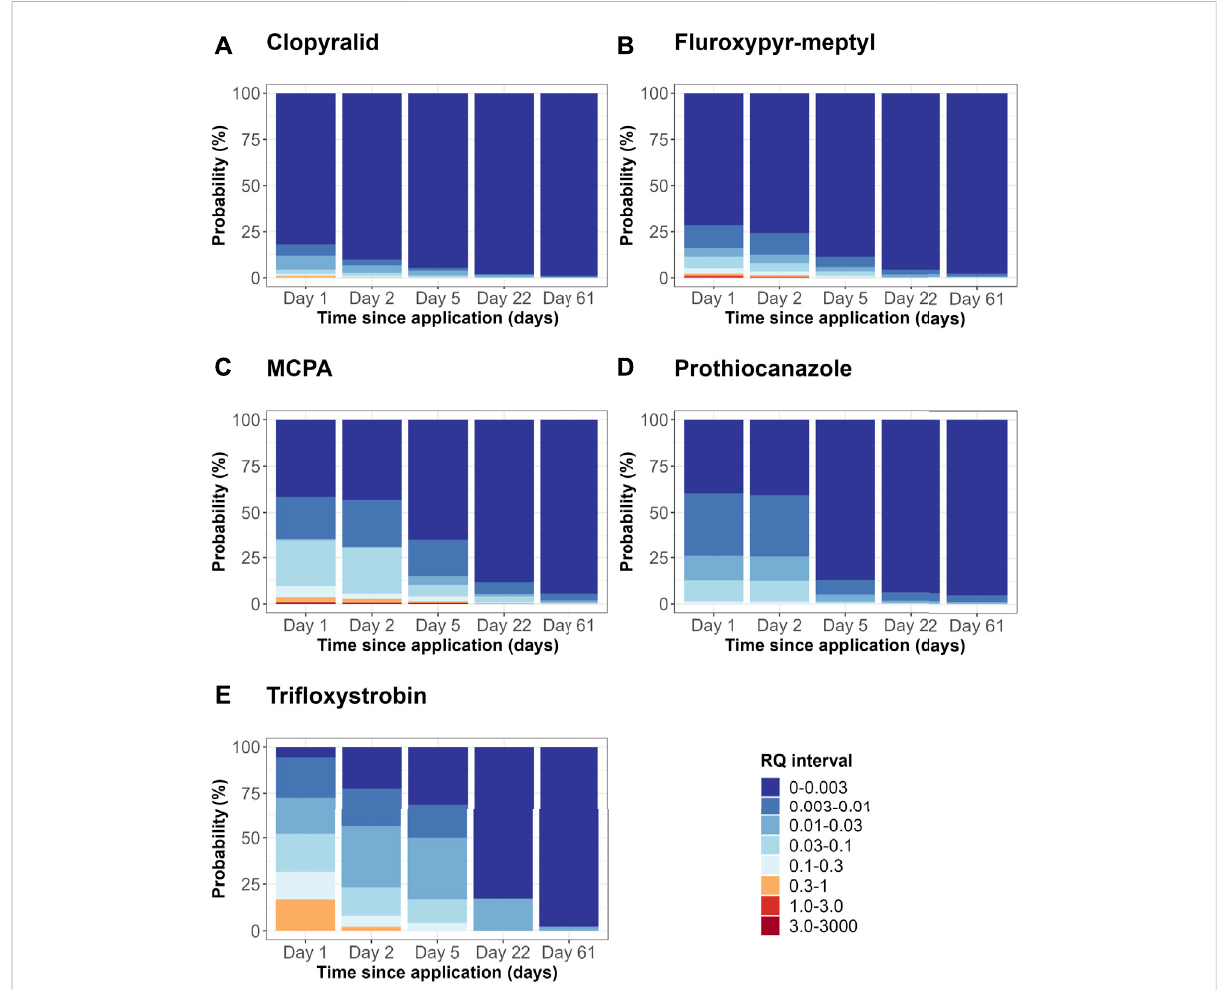
FIGURE 5 Example of predicted risk quotient distribution for clopyralid (A) , fl uroxypyr-meptyl (B) , MCPA (C) , prothioconazole (D) and tri fl oxystrobin (E) over time for 1, 2, 5, 22, and 61 days after application, for the baseline application scenario, climate model C1 and the time interval of 2070 – 2100 for NOEC-based effect